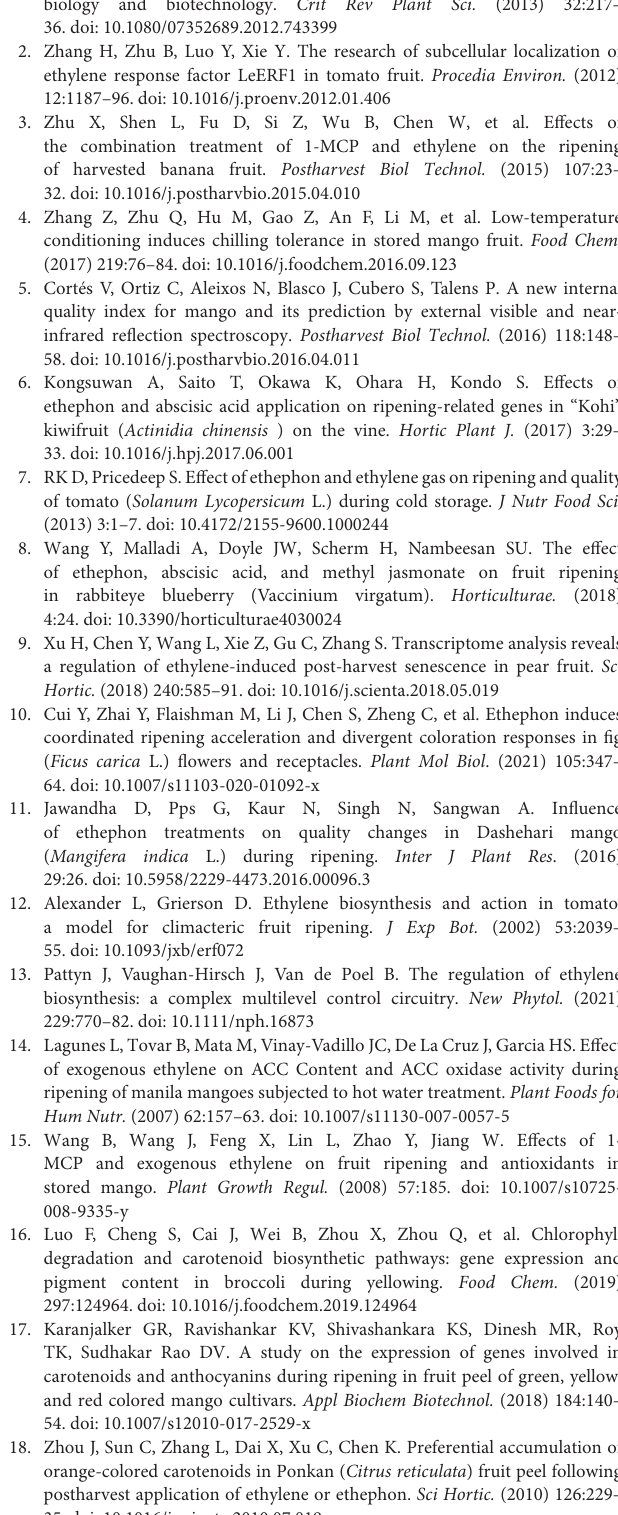
Figueroa PM, et al. Application of a JA-Ile biosynthesis inhibitor to methyl jasmonate-treated strawberry fruit induces upregulation of specific